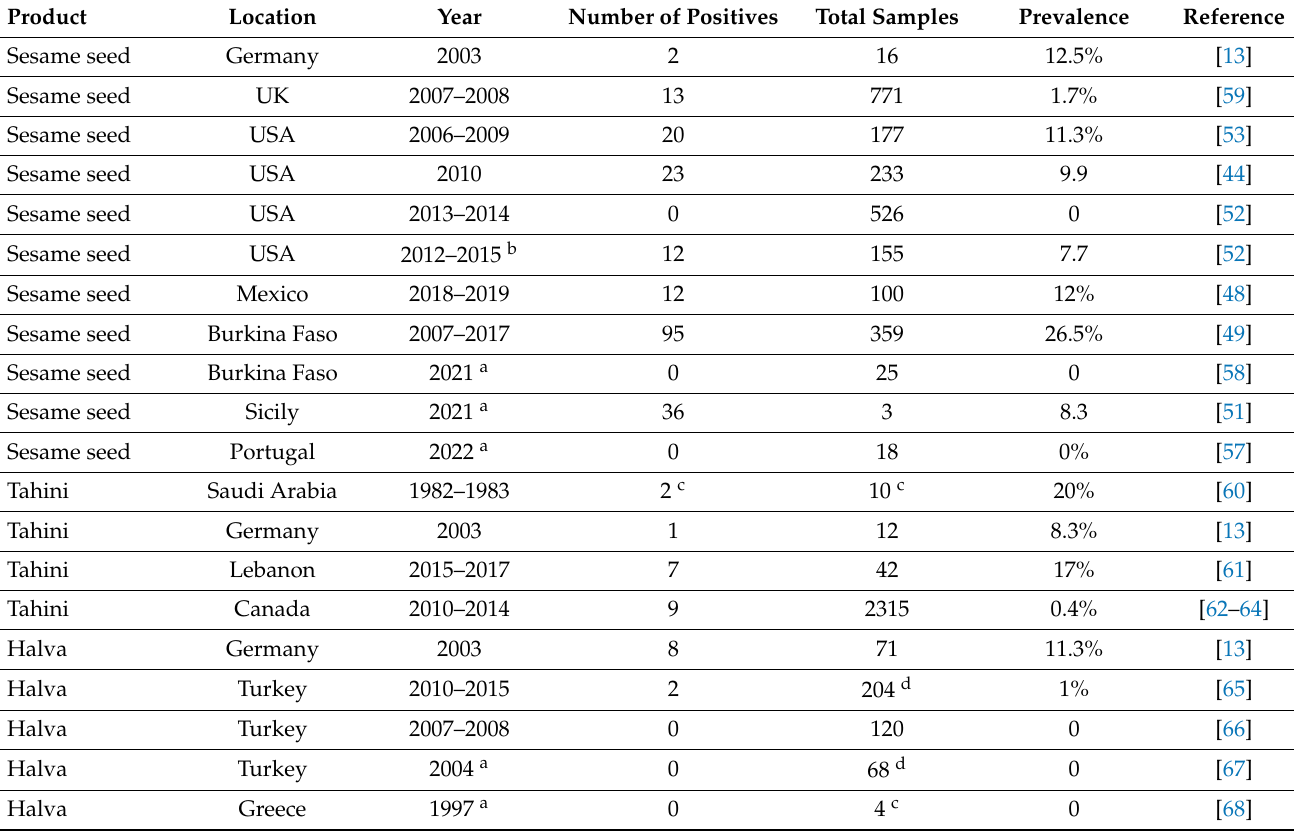
Table 2. Prevalence of Salmonella in sesame seeds, tahini, and